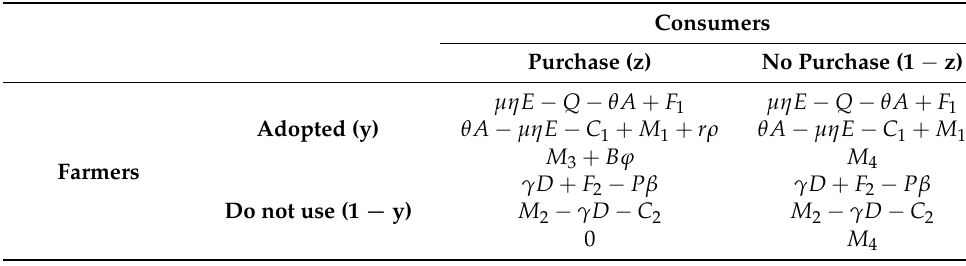
Table 2. The benefit matrix of the farmer-consumer evolutionary game under the background of government